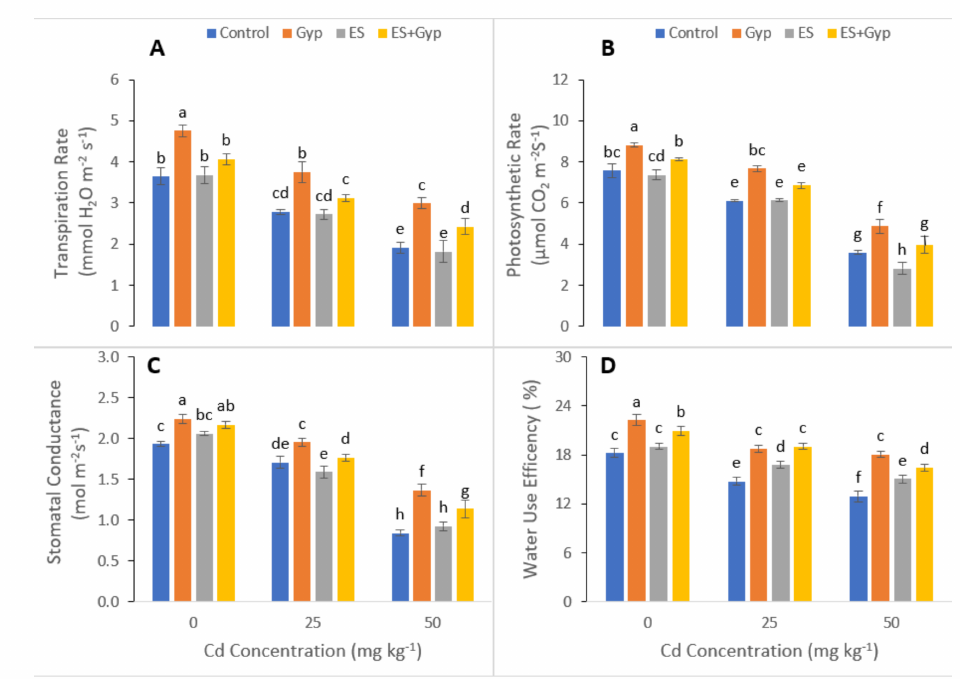
Figure 3. Effect of different concentrations of Cd (25, 50 mg kg − 1 ) in the soil on photosynthetic pigments i.e., transpiration rate ( A ), photosynthetic rate ( B ), stomatal conductance ( C ), and water use efficiency ( D ) of S. nigrum grown under the S-fertilizers, separate from GYP, ES and in combination with GYP+ES . S-fertilizer showed significant increase in growth parameters compared to control. Bars sharing different letter(s) for each parameter are significantly different from each other according to Duncan’s multiple rang test ( p < 0.05). All the data represented are the average of four